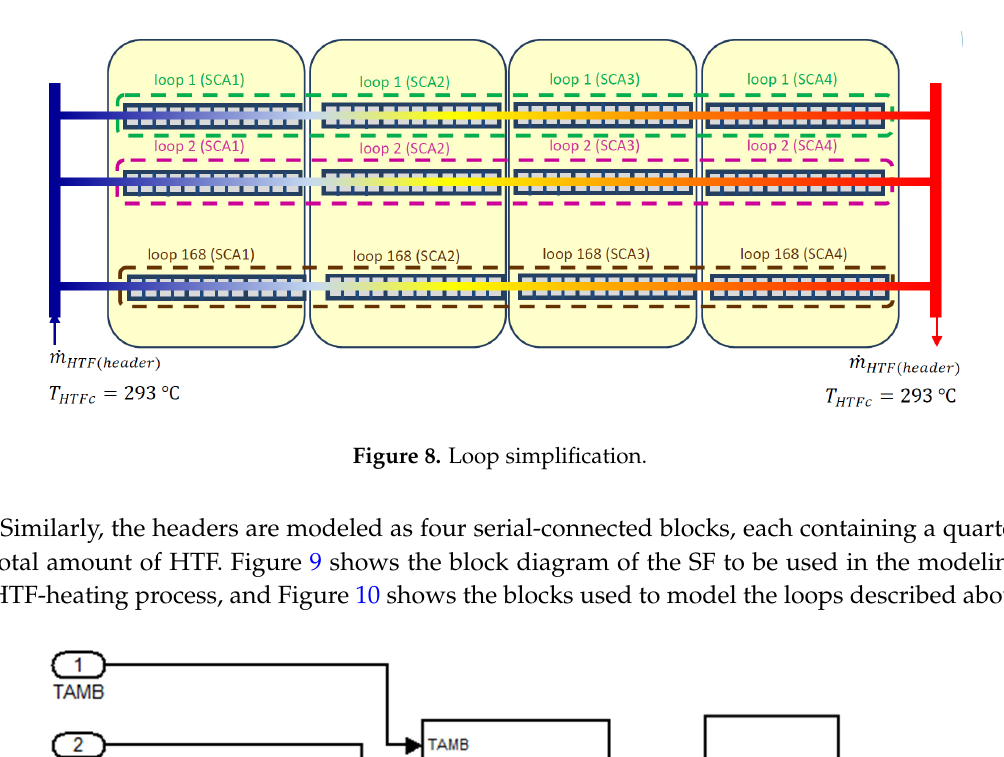
Figure 10. Loops model.